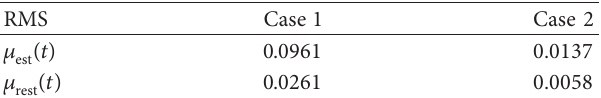
Table 5: Results of RMS error for the estimation and reestimation of 𝜇(𝑡) : case 1 sinusoidal trend and case 2 parabolic